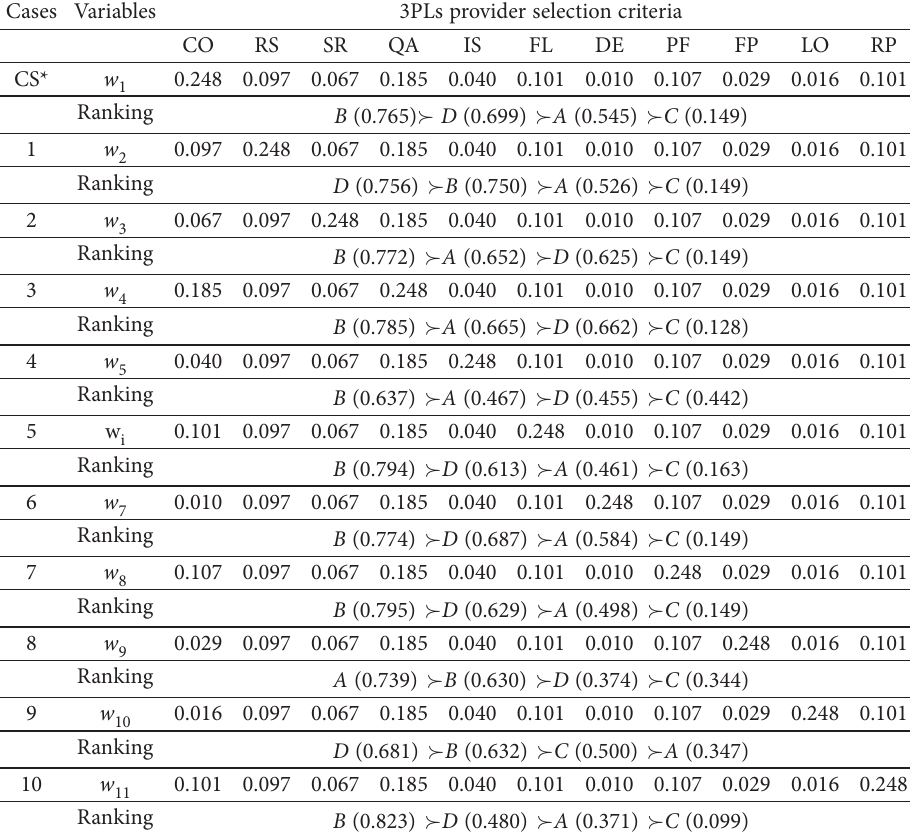
Table 6. The results of sensitivity